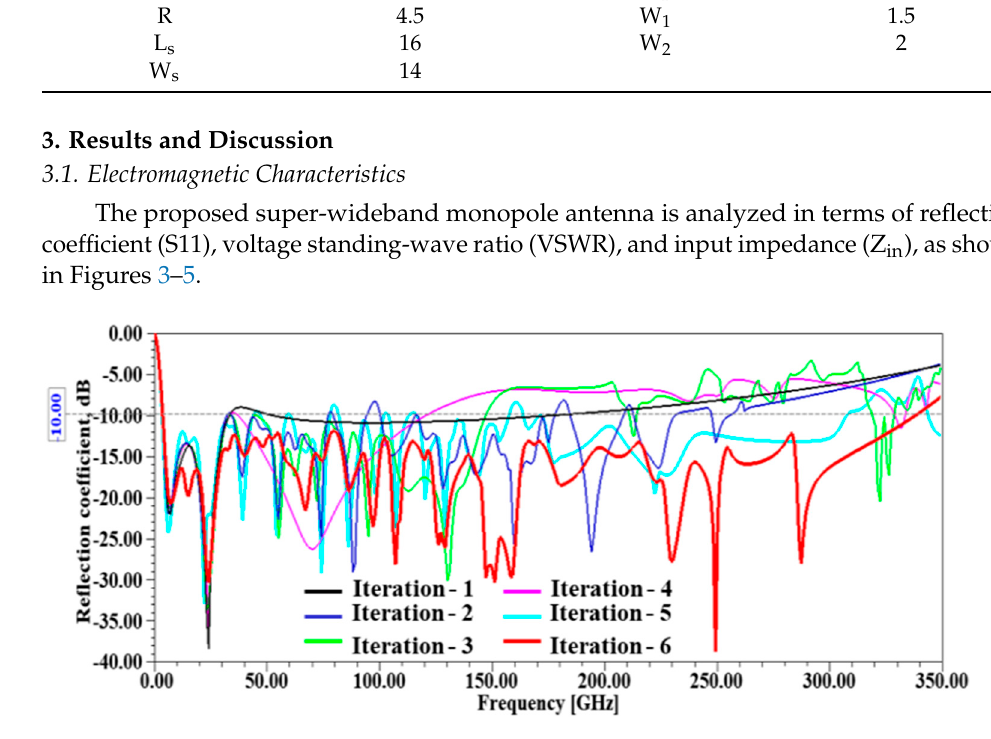
Figure 3. Simulated reflection − coefficient of proposed antenna.